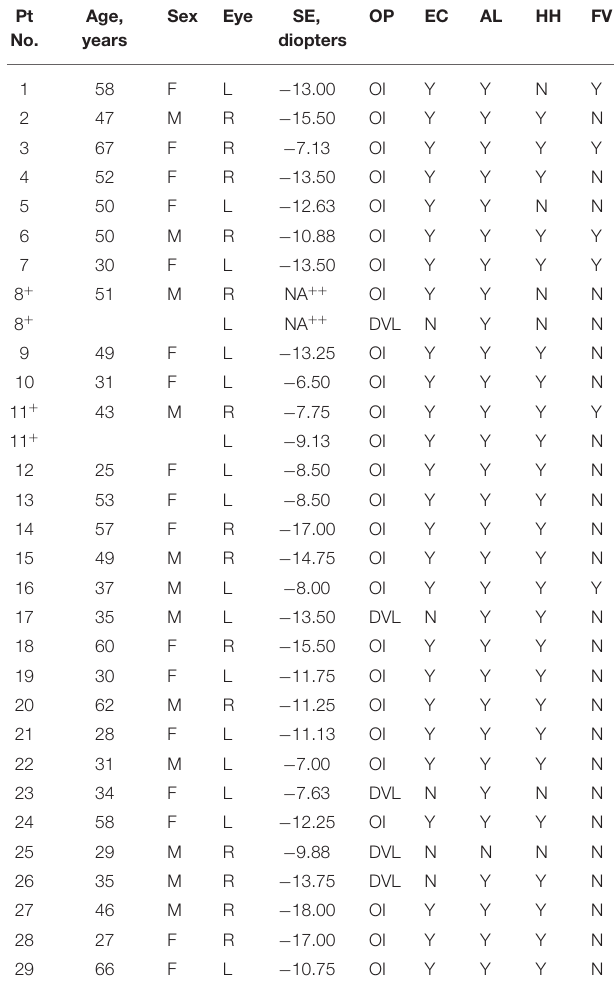
Pt No., patient number; SE, Spherical Equivalent; OP, Overall Pattern; OI, Organized Interlacing; DVL, Disorganized Vascular Loops; EC, Exuberant Capillaries; AL, Anastomoses and Loops; HH, Hypointense Halo; FV, Feeder Vessel; F, Female; M, Male; R, Right eye; L, Left eye; N, No; Y, Yes; 8 + and 11 + mean that two eyes of each patient were included; NA ++ means that we didn’t obtain the diopter of eye, but axial length of right eyeball was 30.59mm and axial length of right eyeball was 29.84 mm.